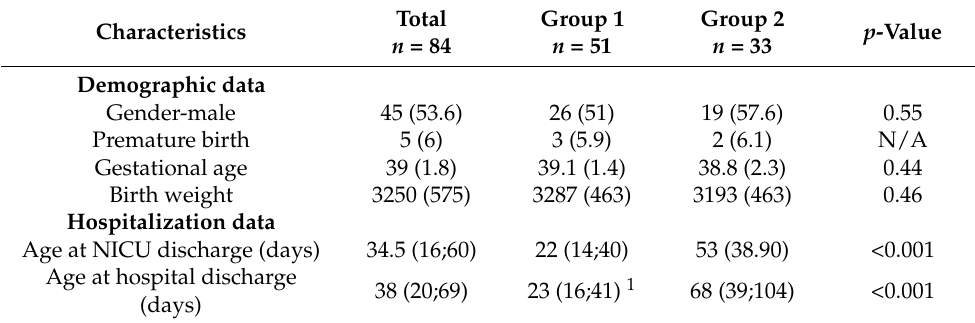
Table 1. Demographic and hospitalization characteristics of the